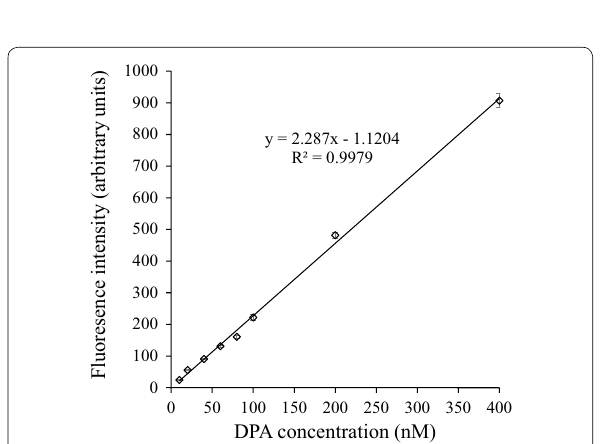
Fig. 3 The standard curve of DPA ranging from 10 to 400 nM